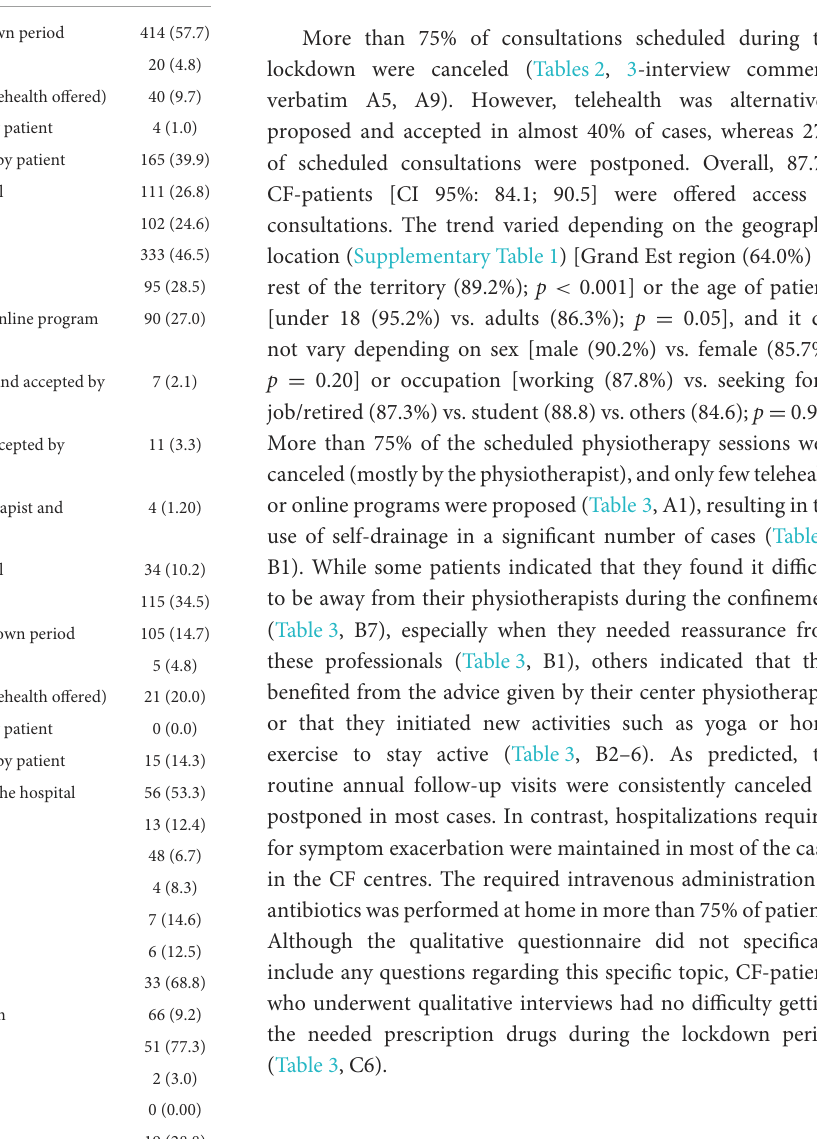
TABLE 2 Use of care by cystic fibrosis (CF) patients during the first lockdown period.